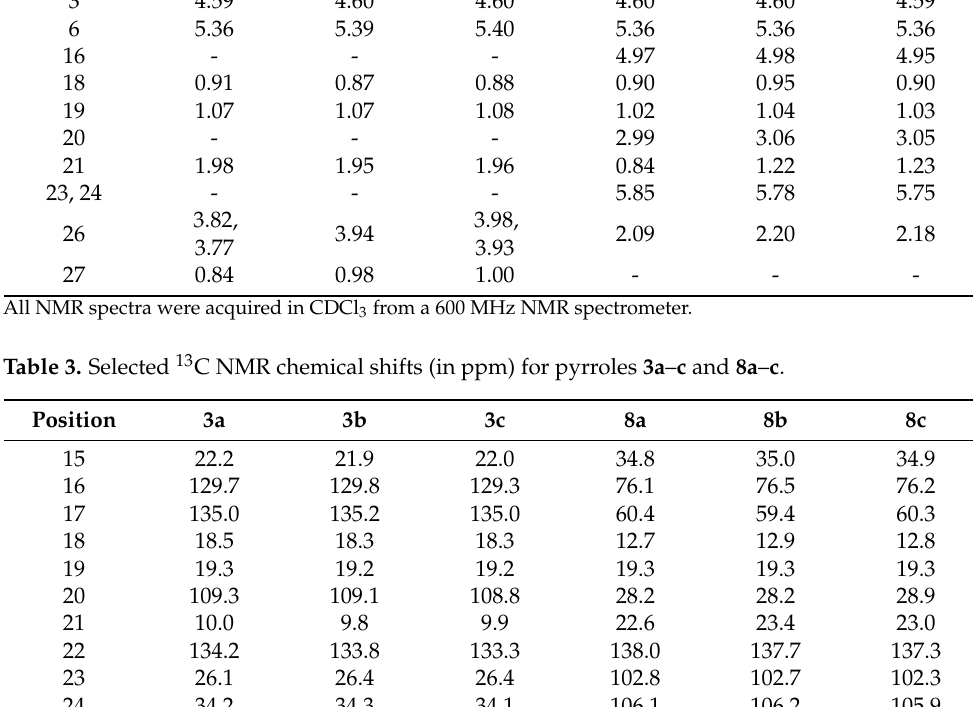
Table 2. Selected 1 H NMR chemical shifts (in ppm) for pyrroles 3a – c and 8a – c . Position